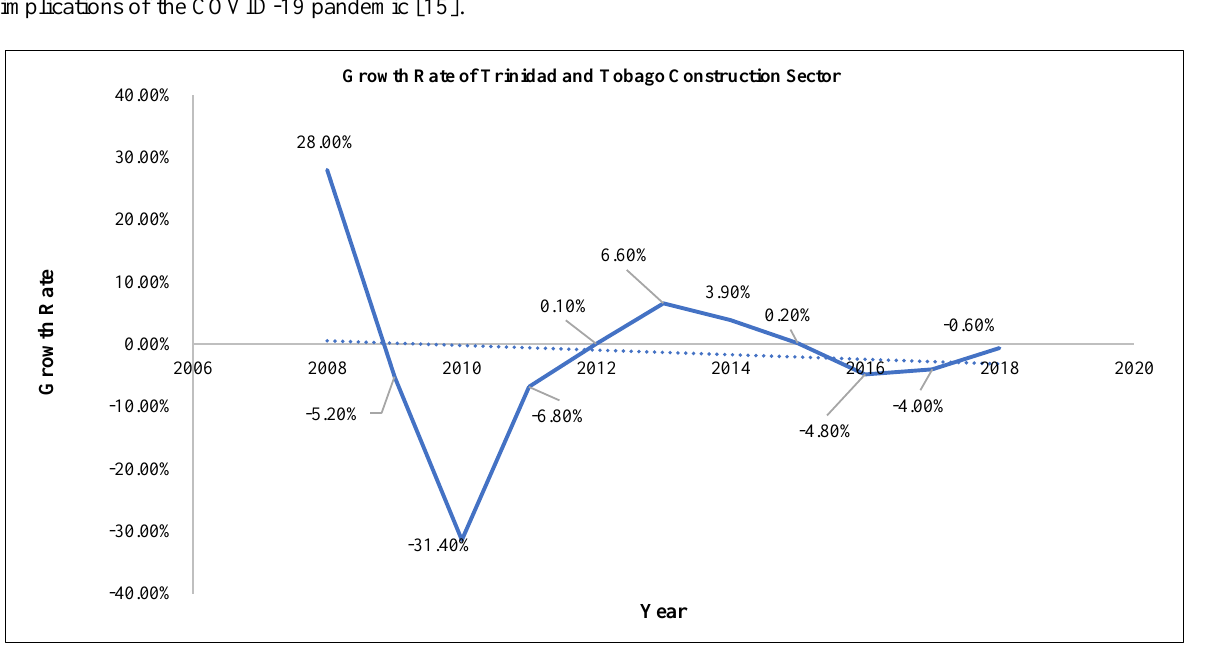
Figure 1. The 10-year rate of growth of the Construction Sector in Trinidad and Tobago (Central Statistics Office